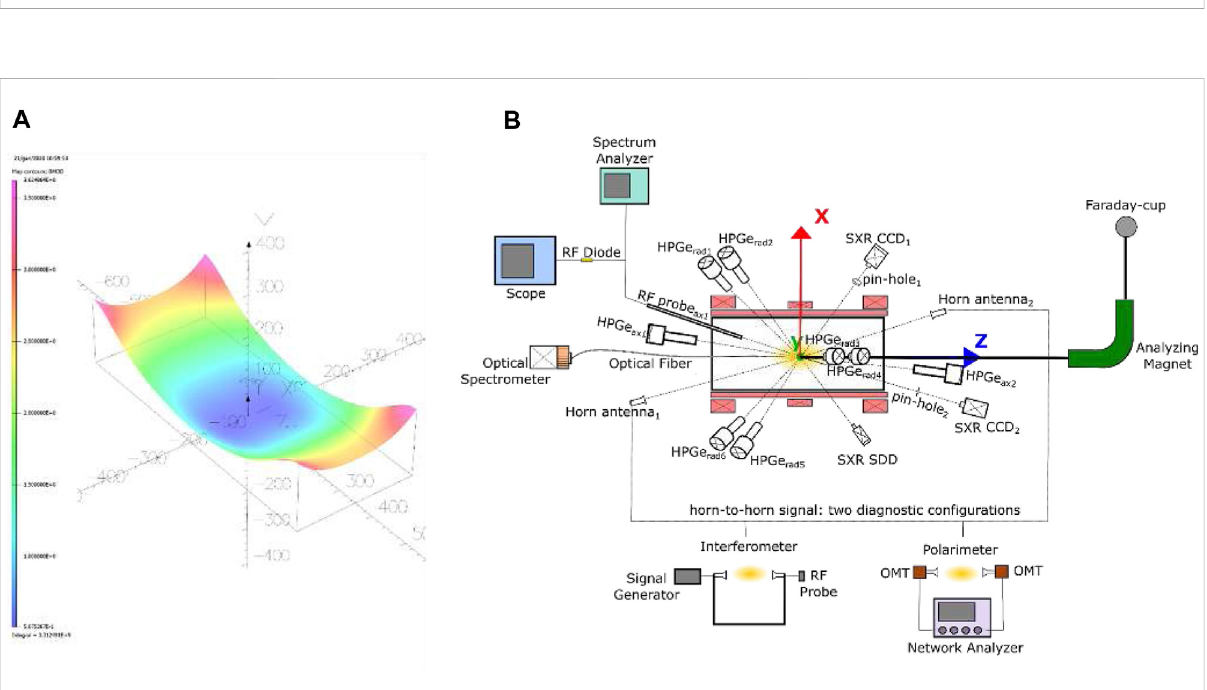
FIGURE 2 (A) 2D (histogram) plot of the magnetic fi eld module | B | inside the plasma chamber, on the xz plane. Values ranges from 1 (violet) to 3.5 (magenta) and are expressed in [T]. (B) Pictorial sketch of the integrated set of PANDORA diagnostics, highlighting the detectors for X-ray spectroscopy and imaging, optical emission spectroscopy and